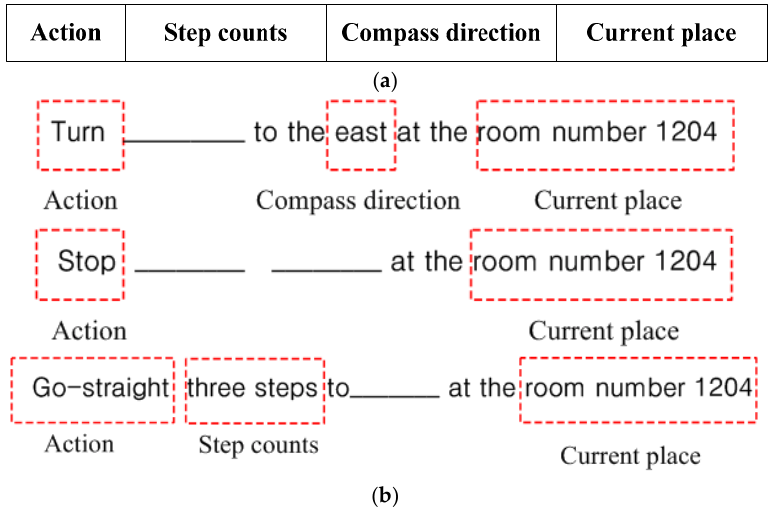
Figure 8. Activity-based instruction: ( a ) Structure of the instruction statement; ( b ) Three types of instructions according to the actions.